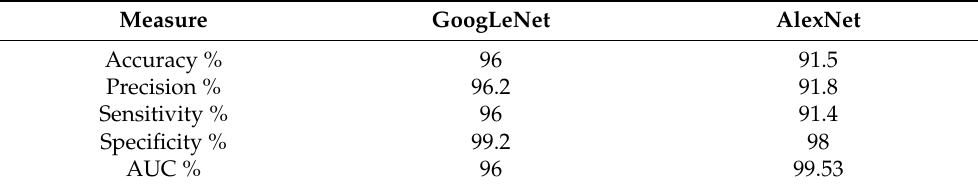
Table 5. The results of the GoogLeNet and AlexNet models on the lower GI dataset.